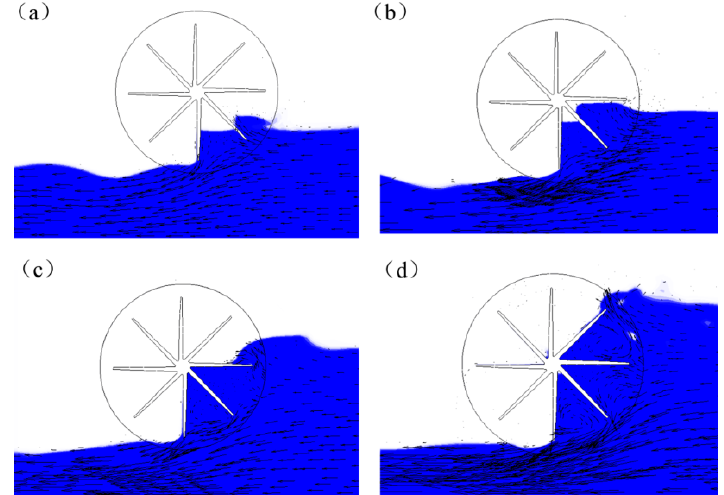
Figure 12. Velocity vectors at circumferential angle ϕ = 135 ◦ . ( a ) The immersed depth of 0.6 m; ( b ) the immersed depth of 0.8 m; ( c ) the immersed depth of 1.0 m; ( d ) the immersed depth of 1.2 m.